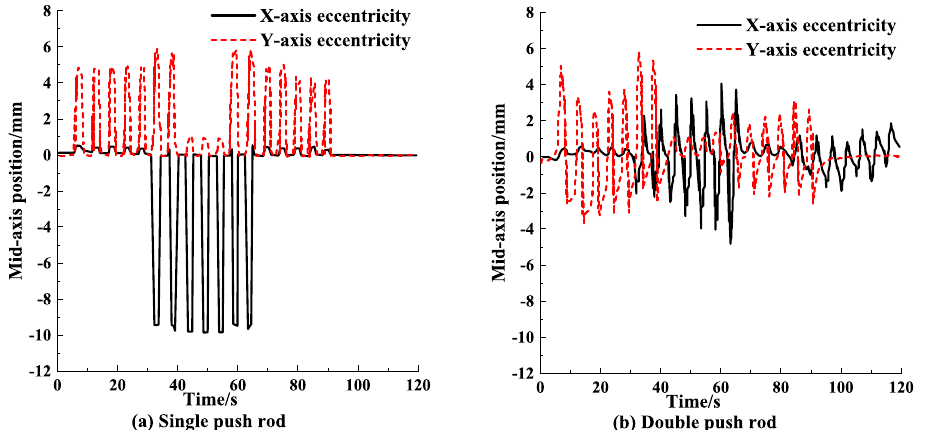
Figure 15. The displacement of the mid − axis of the single push rod support adjustment mechanism, double push rod − double spring support adjustment mechanism across the casing reduction and casing